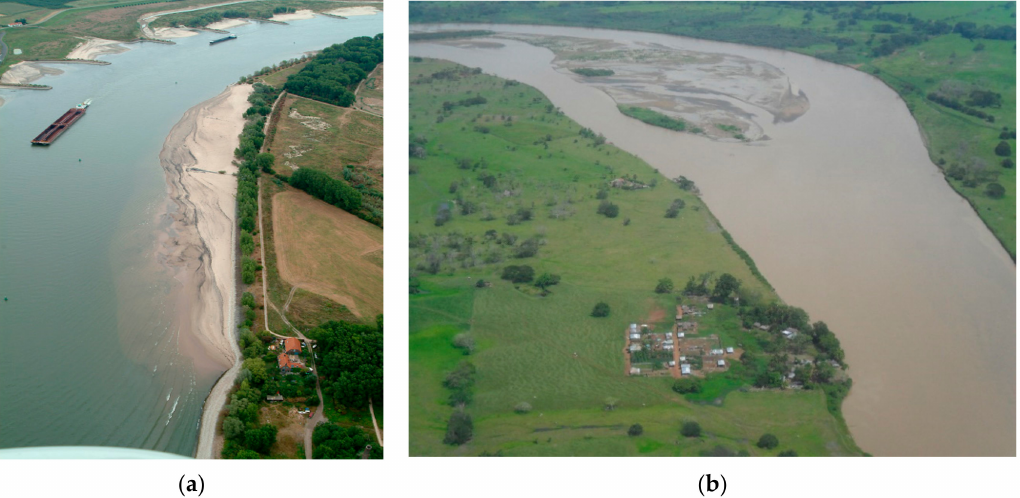
Figure 2. ( a ) Rhine River, the Netherlands. Point bar inside a river bend, forced by channel curvature, hinders navigation. Flow direction from top to bottom. ( b ) Cauca River, Colombia. Compound central bar forced by a local width expansion. Flow direction from bottom to top.